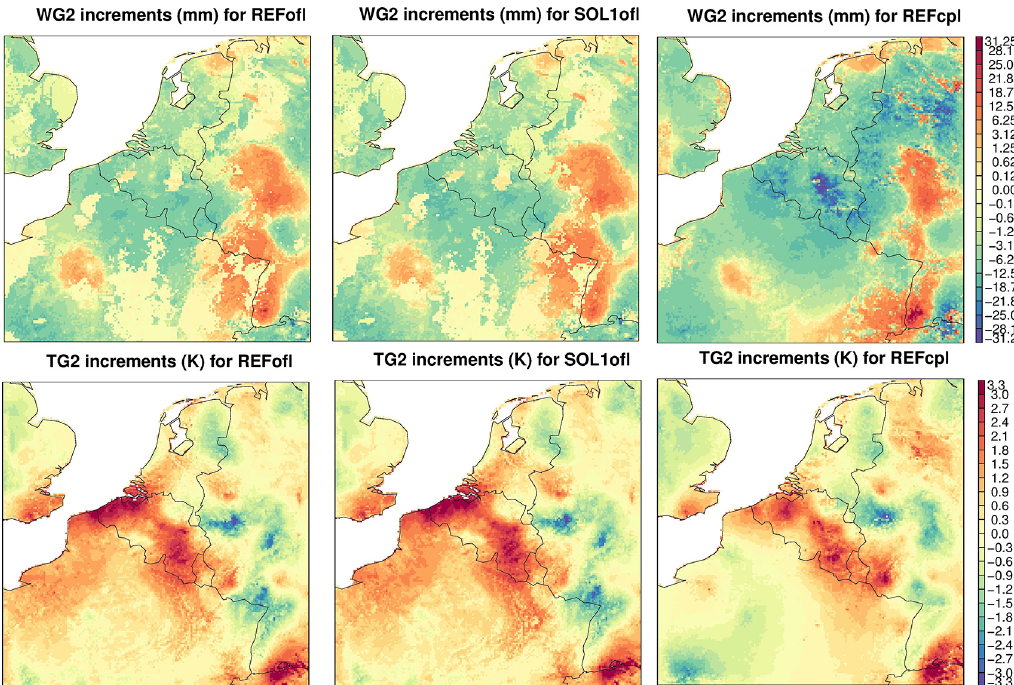
Figure 12. Map of the increments (analysis background) for W 2 (in mm) and T 2 (in K) on 6 July 2010 for REFofl, FILofl and